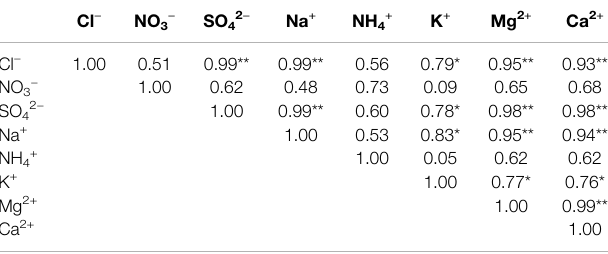
01 neq · m − 3 . Table 1 showed that the total number of cations TABLE 1 | Correlation coef fi cients of the soluble ions in aerosol samples.